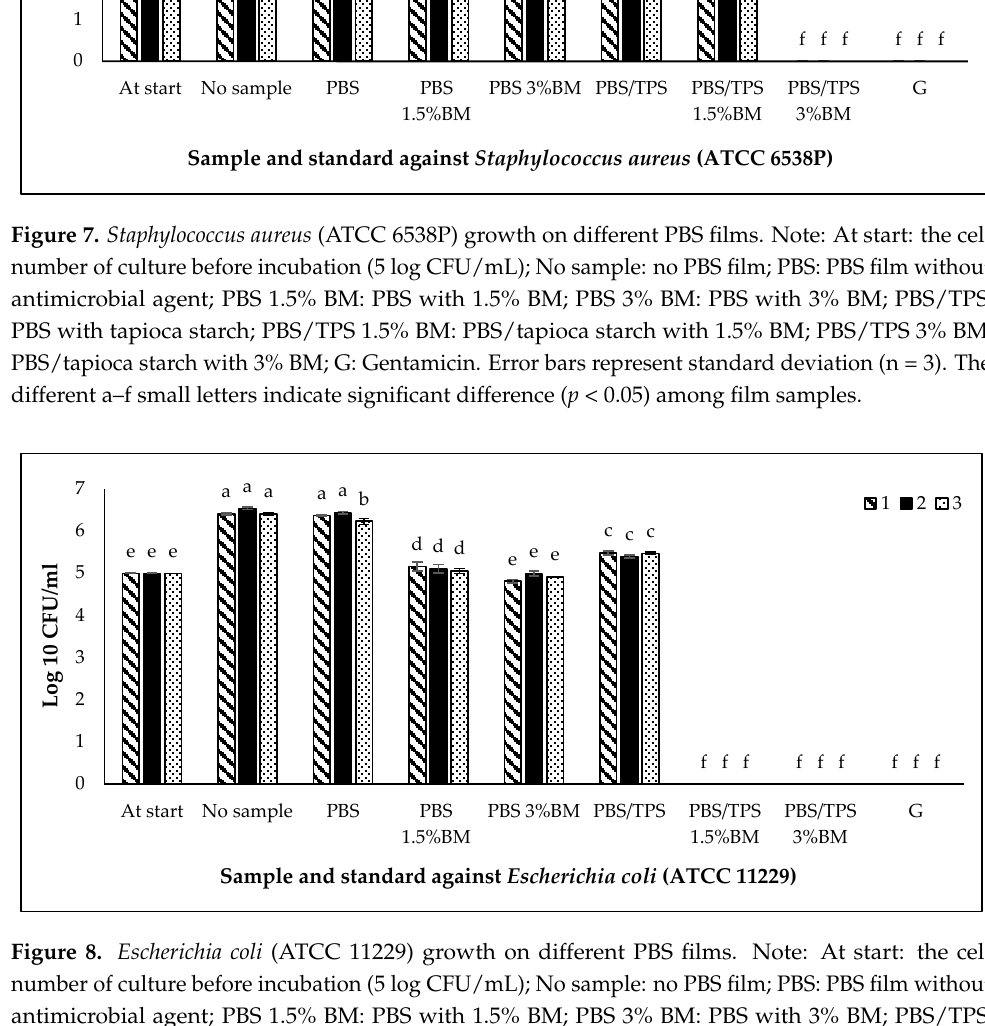
Figure 8. Escherichia coli (ATCC 11229) growth on different PBS films. Note: At start: the cell number of culture before incubation (5 log CFU/mL); No sample: no PBS film; PBS: PBS film without antimicrobial agent; PBS 1.5% BM: PBS with 1.5% BM; PBS 3% BM: PBS with 3% BM; PBS/TPS: PBS with tapioca starch; PBS/TPS 1.5% BM: PBS/tapioca starch with 1.5% BM; PBS/TPS 3% BM: PBS/tapioca starch with 3% BM; G: Gentamicin. Error bars represent standard deviation (n = 3). The different a–f small letters indicate significant difference ( p < 0.05) among film